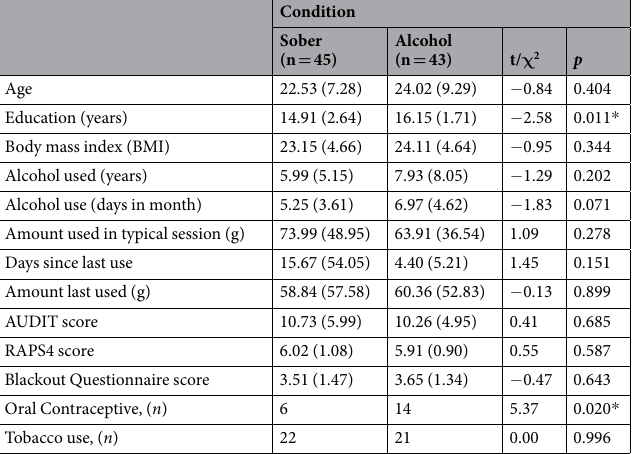
Table 1. Participant Demographics (Means and SD) Between Conditions. The self-report measures: high AUDIT scores indicate increased harmful drinking behaviour; high RAPS4 scores indicate higher alcohol dependence; high Blackout Questionnaire scores indicate increased experience of blackouts when intoxicated.